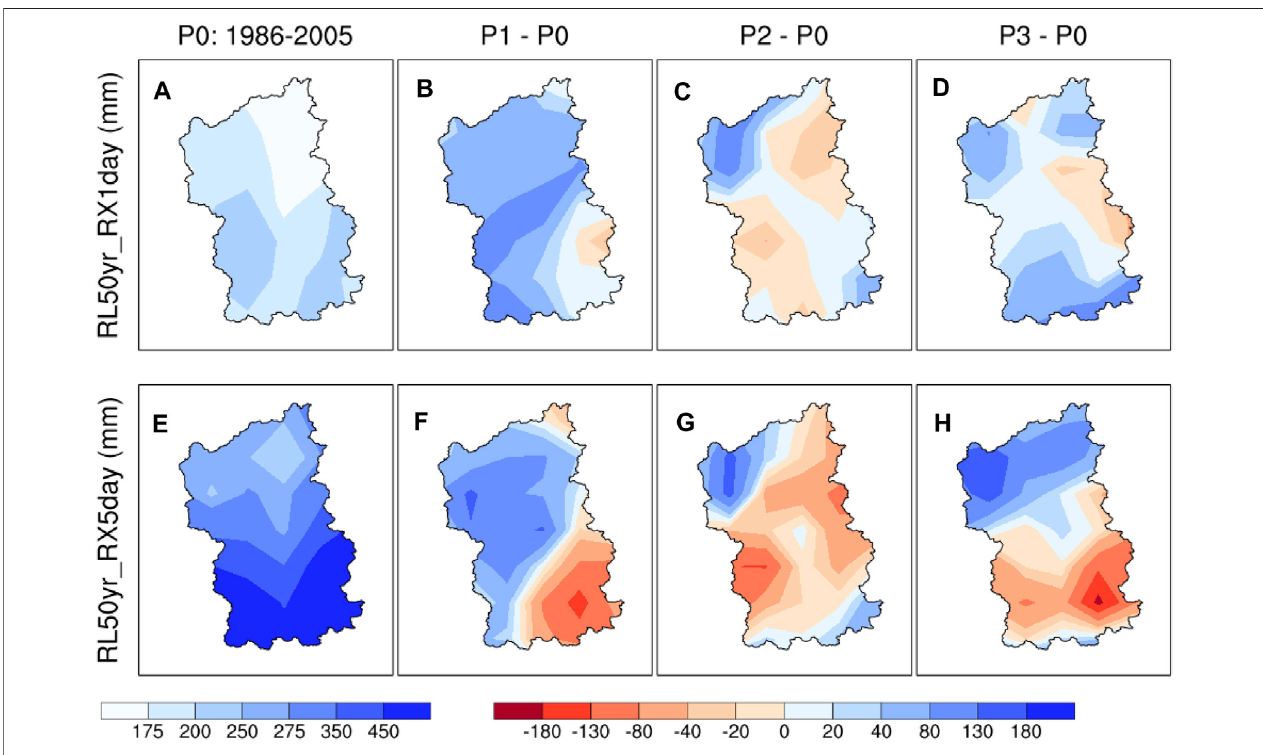
FIGURE 5 | Spatial distribution of present-day (P0: 1986 – 2005) 50-year return level for (A) RX1day and (E) RX5day for the entire rainy season in JRB, and the projected changes in 50-year return level for (B – D) RX1day and (F – H) RX5day during the near-future P1 (2021 – 2040), mid-future P2 (2041 – 2060), and far-future P3 (2081 – 2098) relative to the